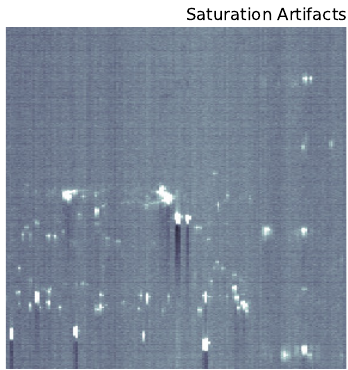
Figure 4. Saturation spikes as saturated sources are read off of the CCD.